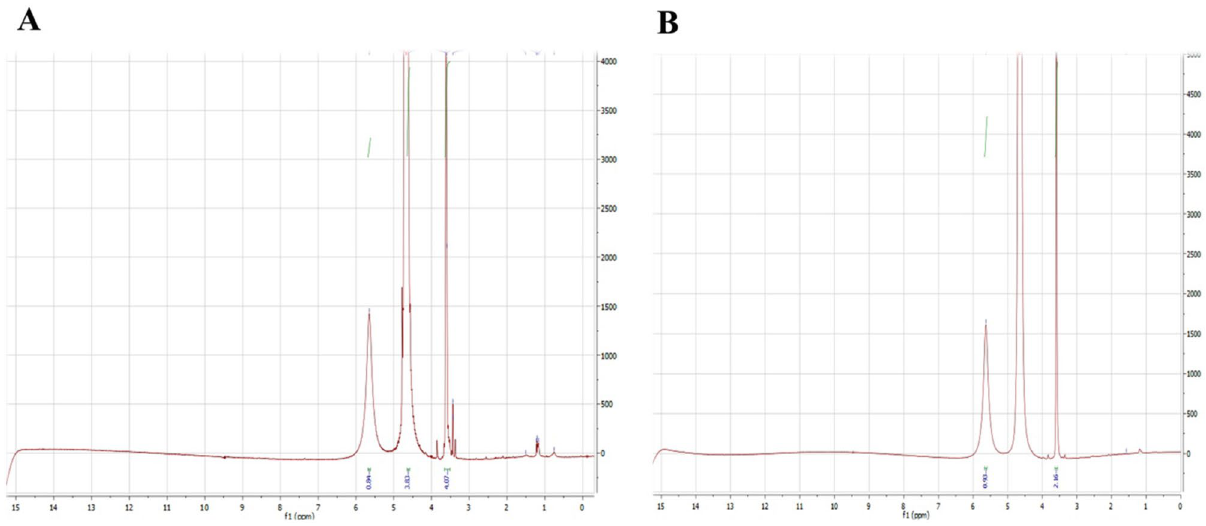
Figure 8. NMR analysis of recombinant proteins: (A) YFL001; ( B) YFL002. Spectral data was analyzed using MestreNova